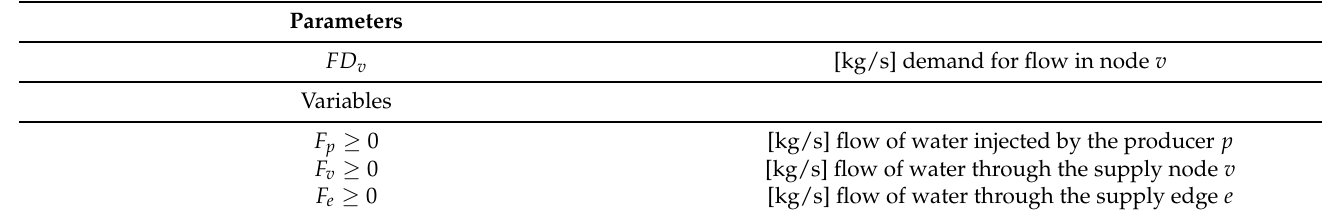
Table A2. List of parameters and variables used in the flow model